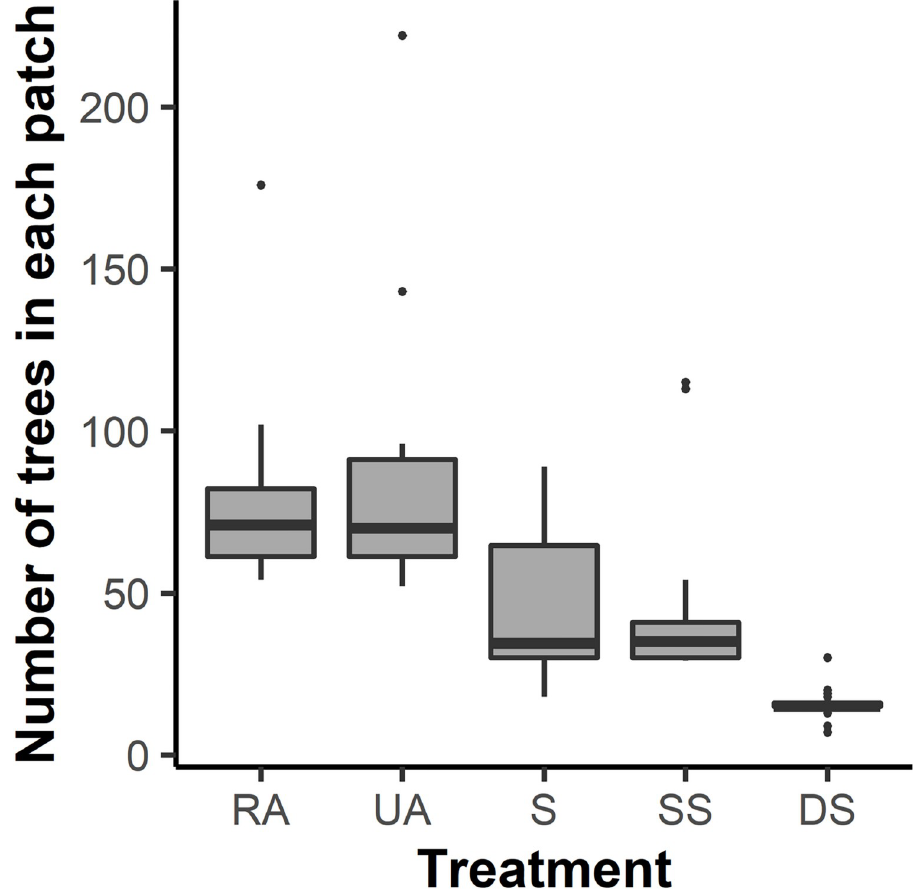
Fig 3. Box and whisker plots depicting variation in patch size among the five retention treatments, northwest Oregon and southwest Washington, USA, 2017–2019. In the box plots horizontal lines indicate the median, boxes represent interquartile range (IQR), and vertical lines represent 1.5 � IQR of patch sizes from each treatment type. Black points are outliers. Treatments were fully replicated in each of 10 experimental blocks ( n = 50). Abbreviations are RA, Riparian Aggregated; UA, Upland Aggregated; S, Split; SS, Split with Snags; and DS, Dispersed with Snags. Stands with the S, SS, and the DS treatments contained multiple patches per stand; each RA and UA treatment stands only contained a single